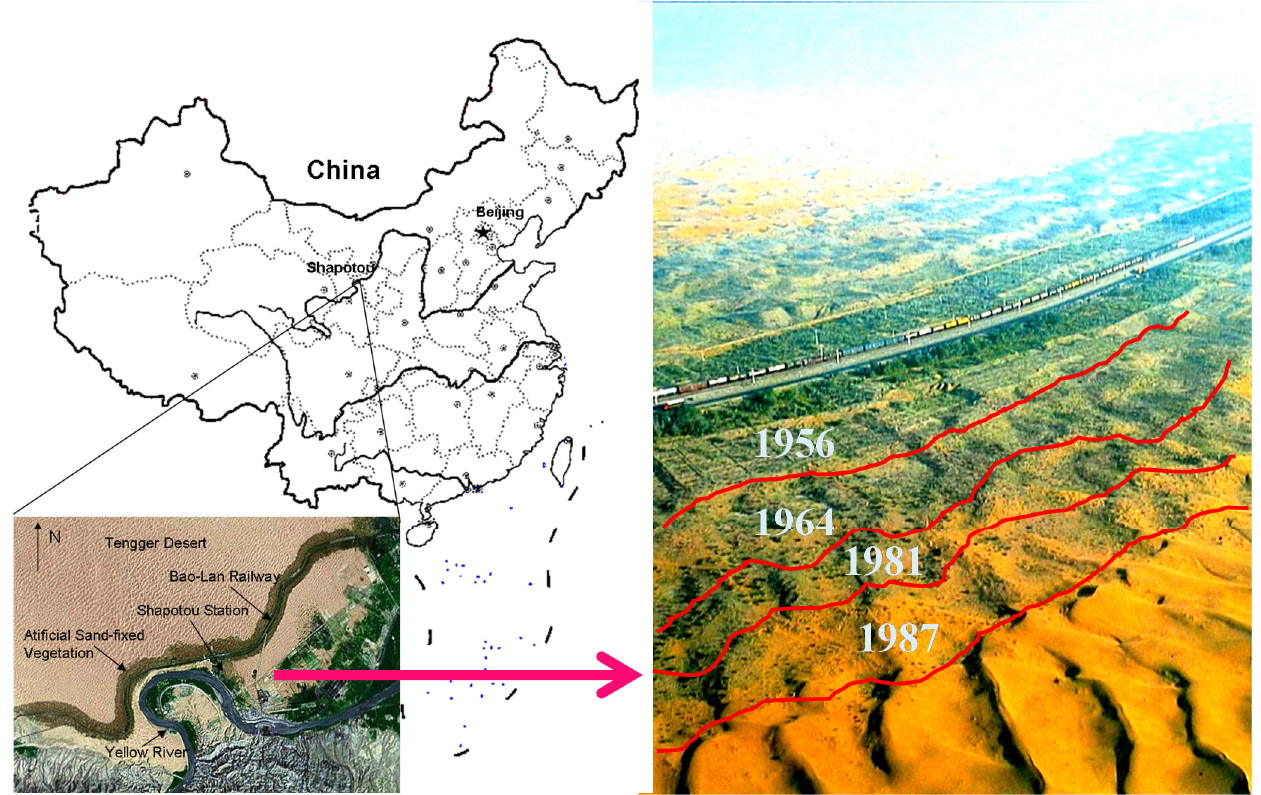
Figure 1. Schematic description of the study site (revegetated in 1956a, 1964a, 1981a and 1987a) in the Shapotou region of the Tengger Desert, northwestern